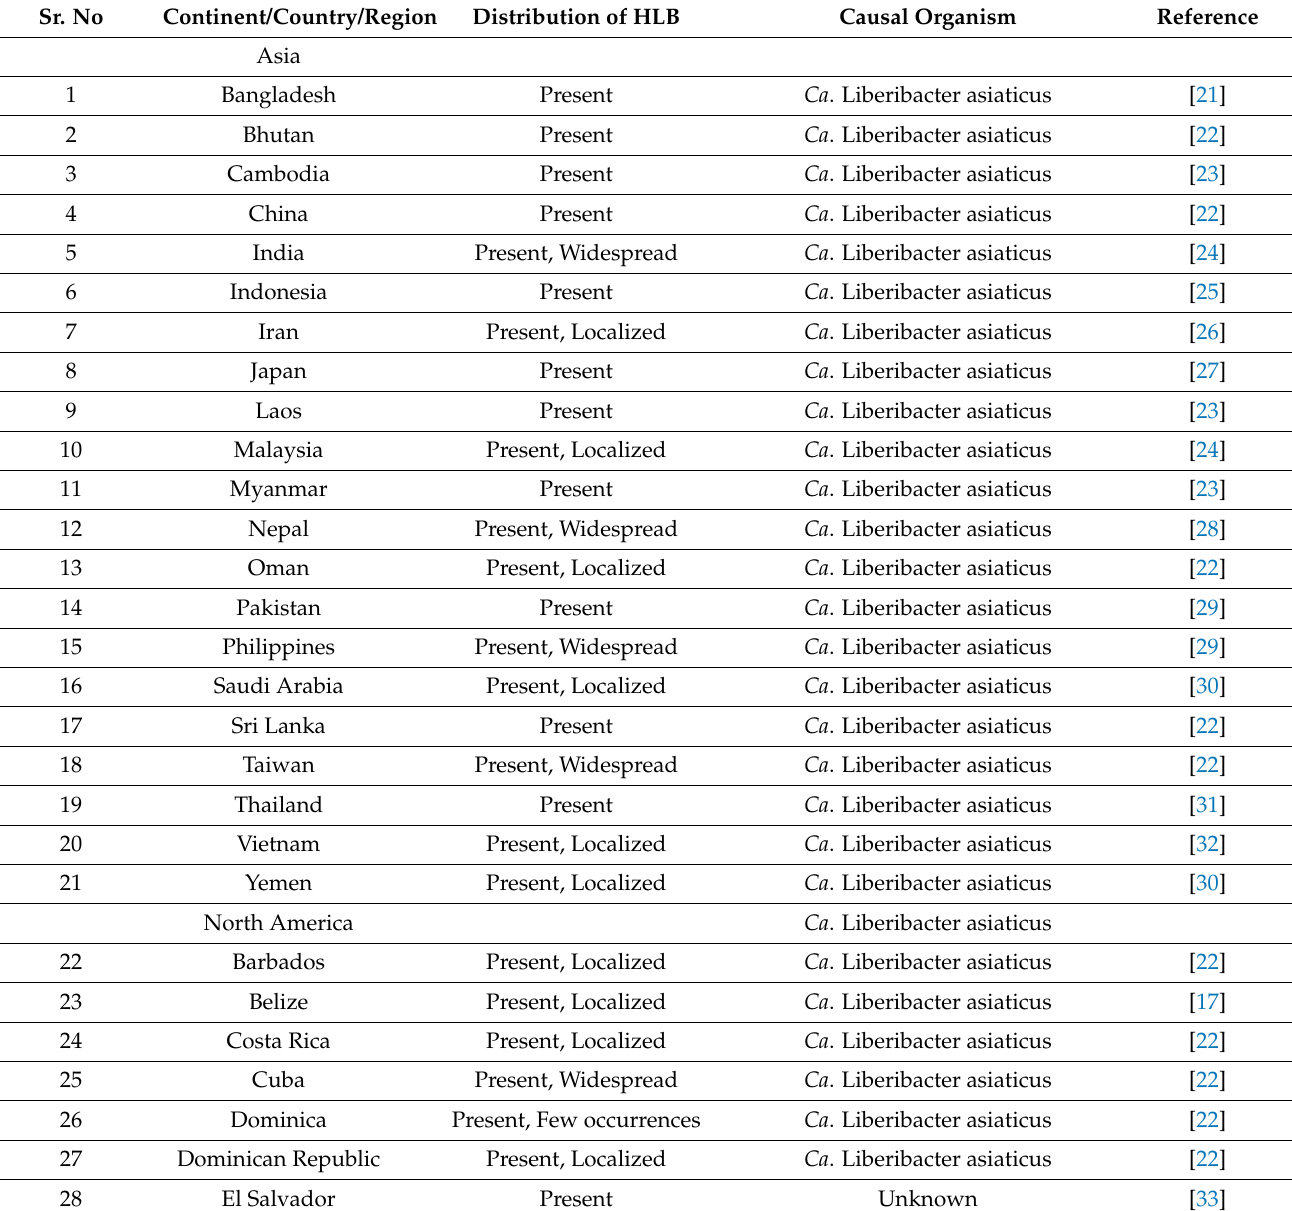
Table 1. Worldwide distribution of HLB